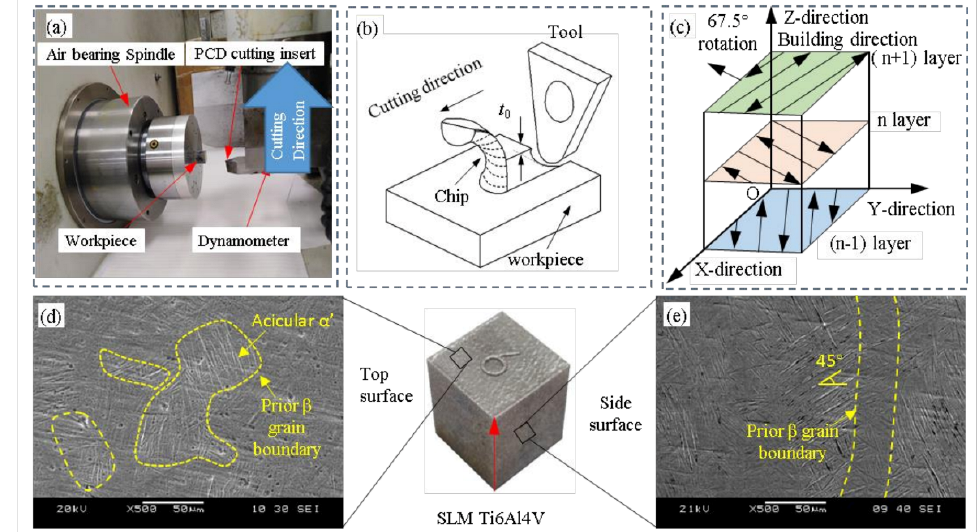
Figure 1. ( a ) Experimental setup; ( b ) schematic of the processing process; ( c ) fabrication strategy of SLM Ti6Al4V; ( d , e ) microstructure of SLM